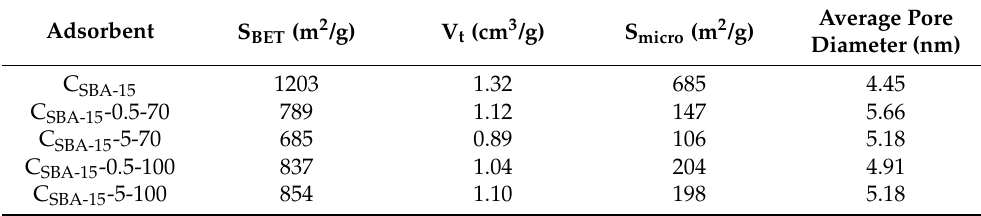
Table 1. Textural parameters of adsorbents obtained 1 . Adsorbent S BET (m 2